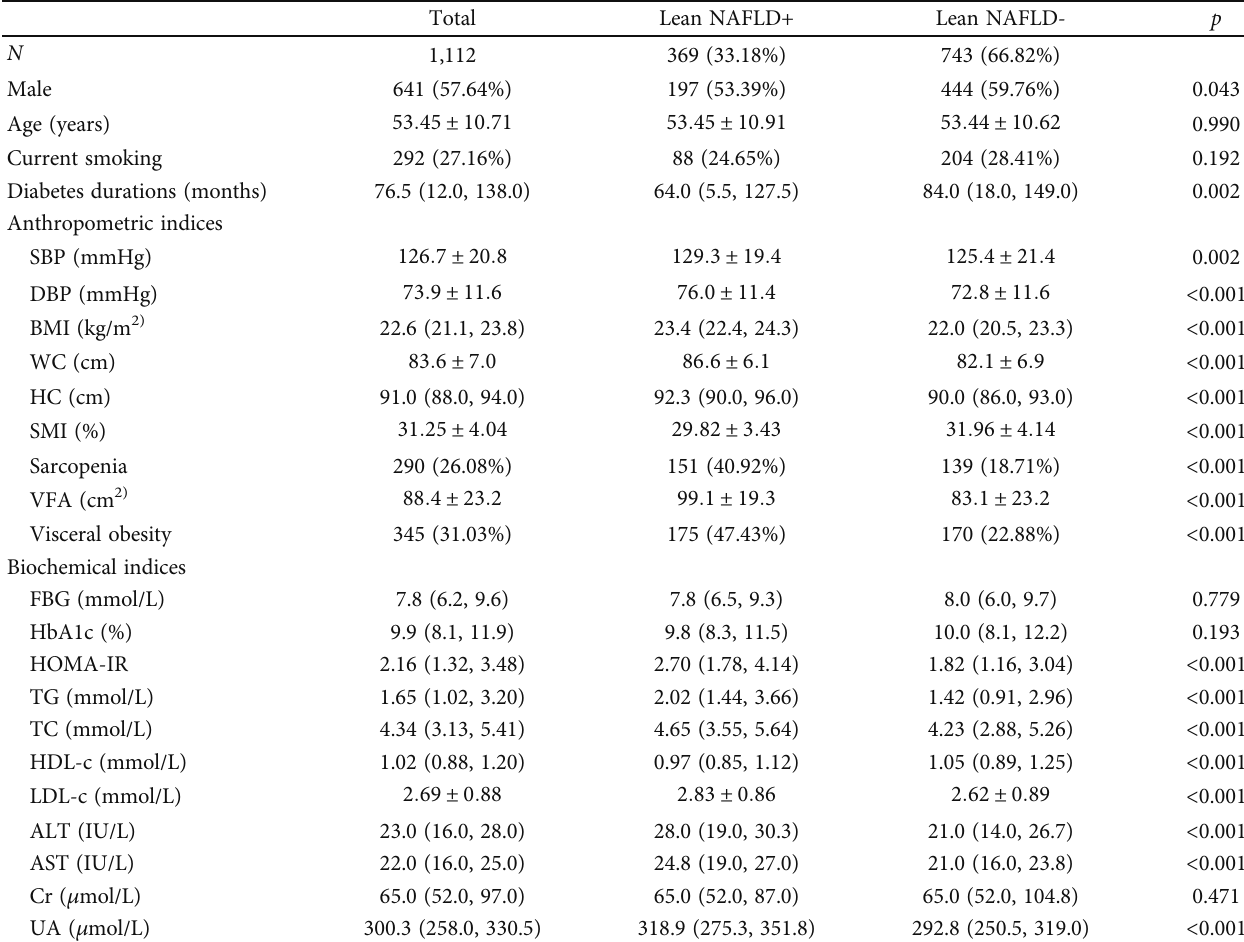
Table 1: Baseline characteristics of study participants according to the status of lean nonalcoholic fatty liver disease. Total Lean